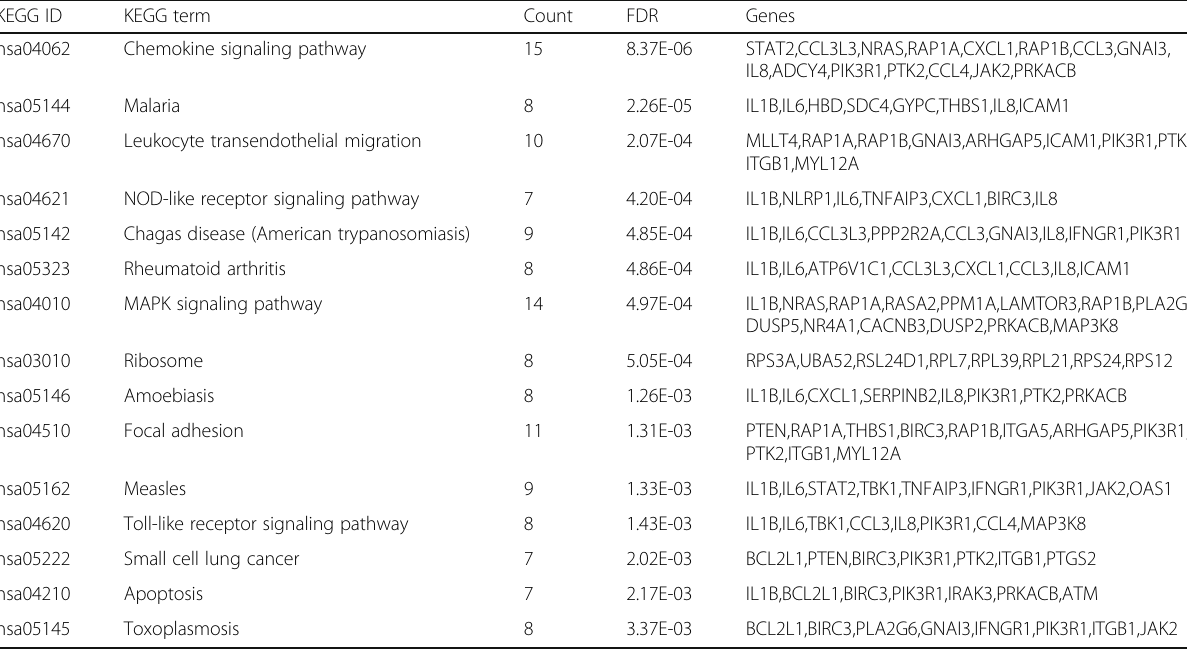
Table 2 The top 15 significantly enriched pathways for differentially expressed genes in CAD KEGG ID